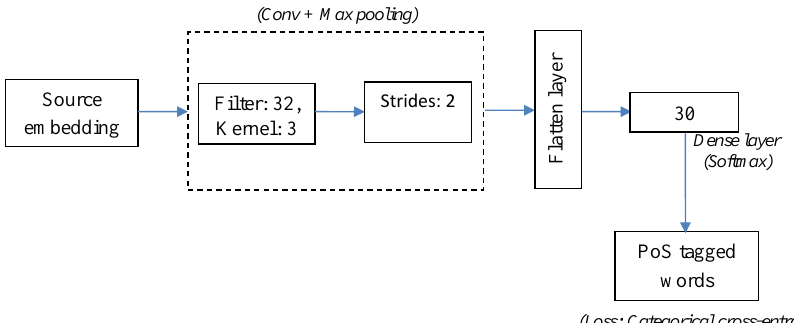
Figure 7. Pipeline of POS Tagger trained using